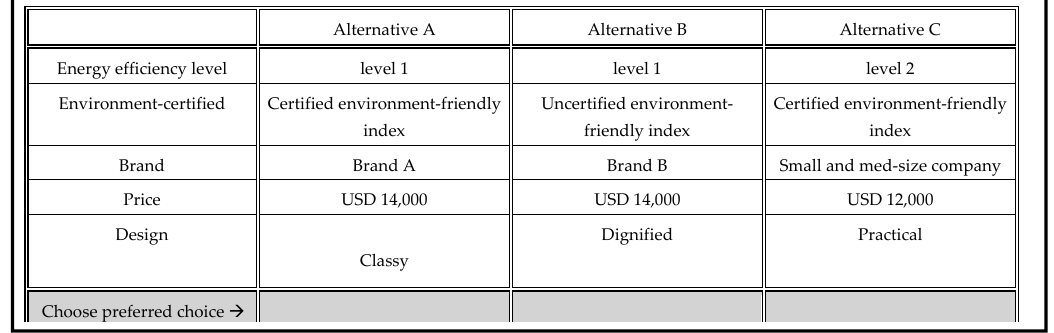
Table 3. Demographic characteristics of the respondents.